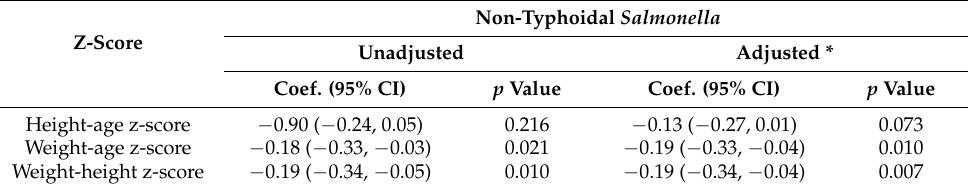
Table 3. Association of non-typhoidal Salmonella (NTS) infection with child’s height-for-age, weight- for-age, and weight-for-height z-scores: results of generalized estimating equations modelling (dependent variables—height-for-age, weight-for-age, and weight-for-height z-scores). Non-Typhoidal Salmonella Z-Score Unadjusted Adjusted * Coef. (95% CI) p Value Coef. (95% CI) p Value Height-age z-score − 0.90 ( − 0.24, 0.05) 0.216 − 0.13 ( − 0.27, 0.01) 0.073 Weight-age z-score − 0.18 ( − 0.33, − 0.03) 0.021 − 0.19 ( − 0.33, − 0.04) 0.010 Weight-height z-score − 0.19 ( − 0.34, − 0.05) 0.010 − 0.19 ( − 0.34, − 0.04)